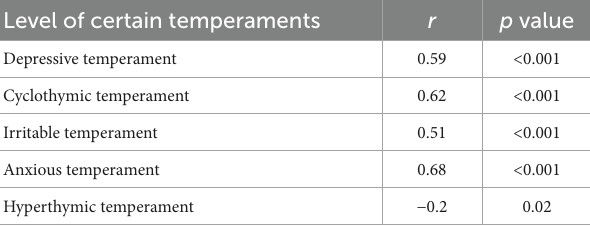
TABLE 3 The correlation between the levels of certain temperaments and depressive